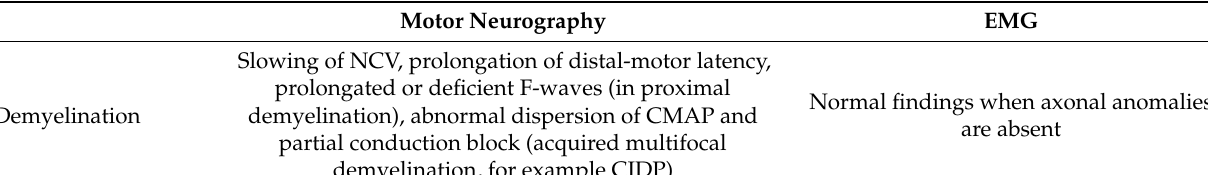
Normal findings when axonal anomalies are absent Florid denervation: fibrillation potentials, positive sharp waves, reduced interference pattern Chronic denervation with re-innervation: abnormal high-amplitude and polyphasic potentials, reduced interference